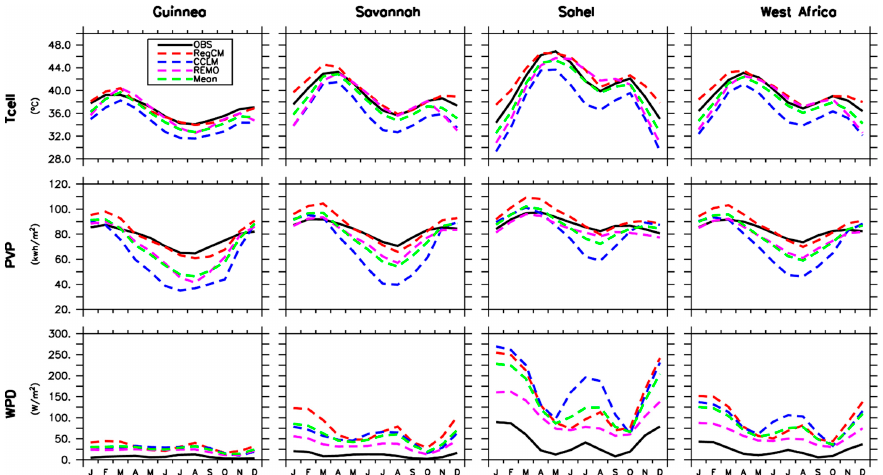
Figure 5. Annual cycle of observed and simulated solar irradiance (RSDS), ambient air temperature (Tas), and surface wind speed (WSPD) over the three climatic zones of West Africa.